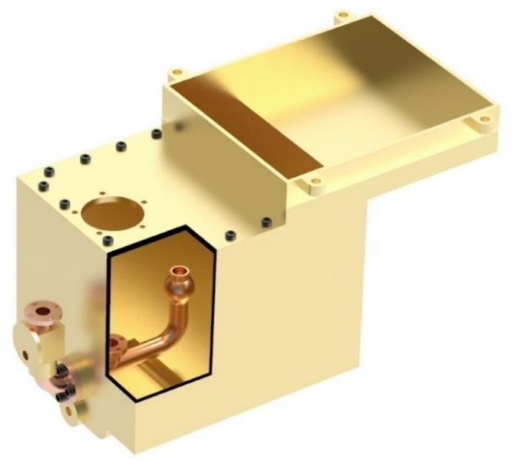
Figure 22. Juice collecting tank